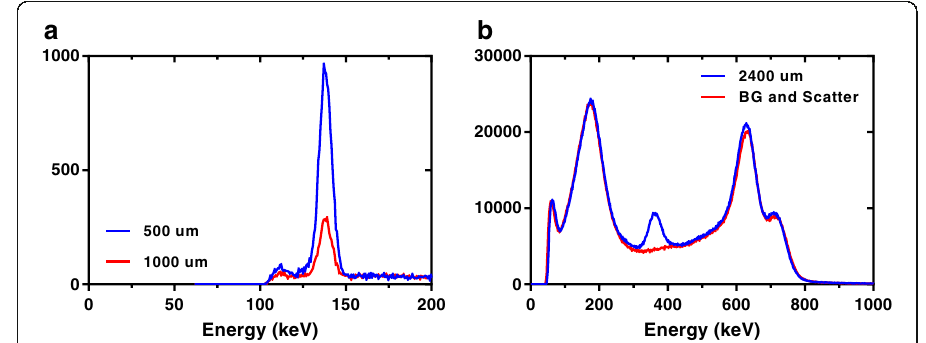
Fig. 6 Obtained energy spectra of a Tc-99m and b I-131 source through different thicknesses of